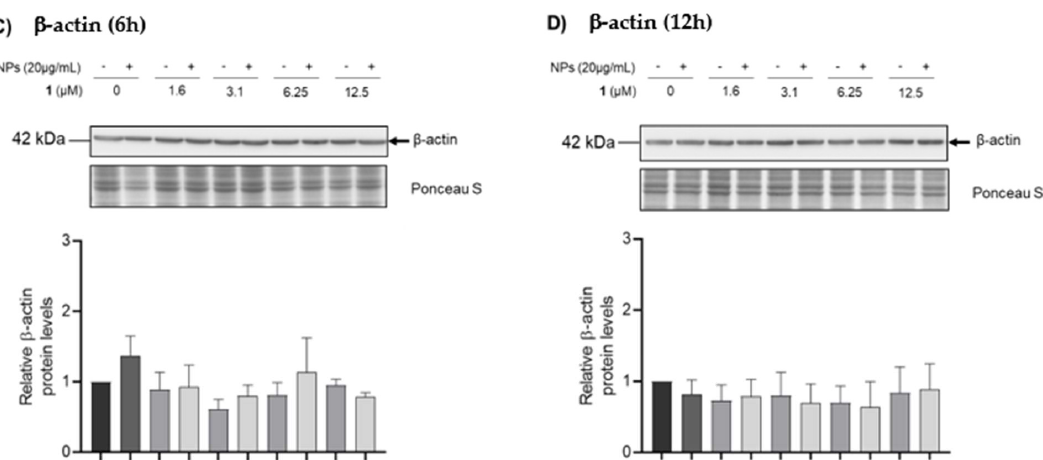
Figure 7. Immunoblotting analysis of cytoskeleton proteins. Acetylated α-tubulin intracellular protein levels of GC-1 cells treated with ZnO NPs (20 µg/mL) and chalcone 1 (0–12.5 µM) for 6 ( A ) and 12 h ( B ). The intracellular protein levels of acetylated α-tubulin were estimated in relation to protein levels detected in the control condition. Ponceau S staining was used to assess gel loading.